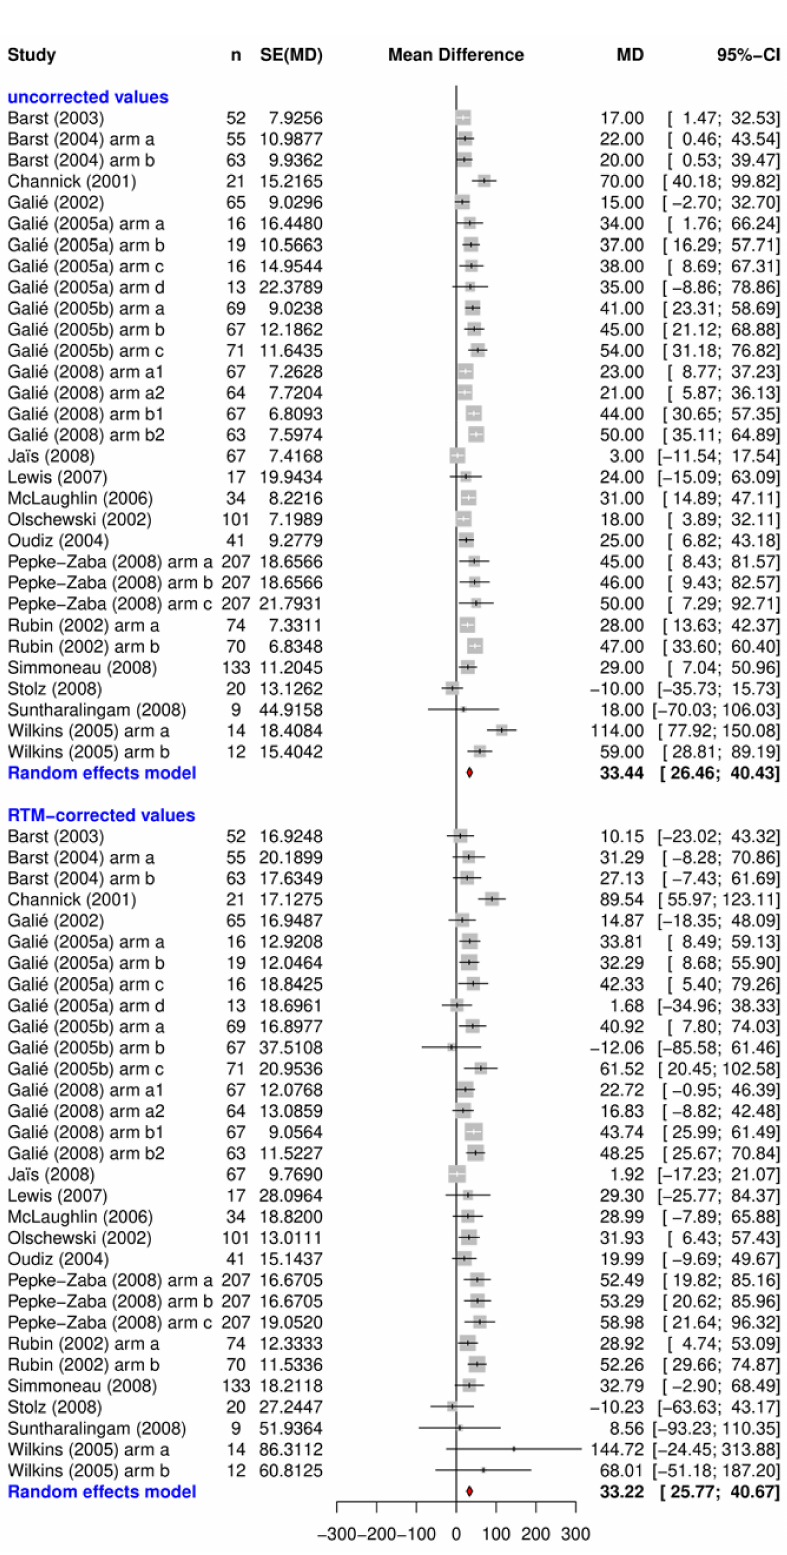
Figure 1. Uncorrected and RTM-corrected treatment effects measured with the 6MWD after 12 weeks from the verum arms. Abbreviations: n = number of participants in study (arms); seTE = standard error of treatment effect; MD = mean difference; 95% CI = 95% confidence in- terval. Note: the difference in numbers between the placebo and the verum group in Figures 1 and 2 can be explained by the fact that many studies compared several treatment groups to only one single placebo